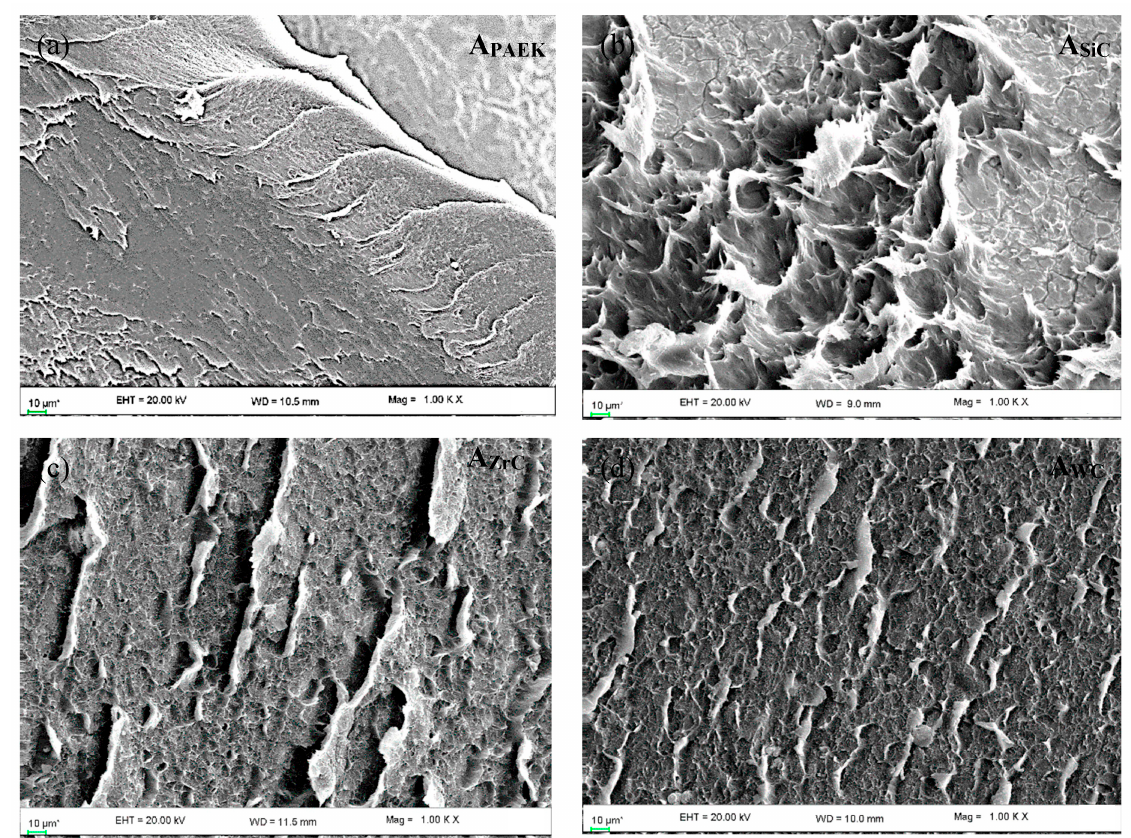
Figure 12. SEM mizcrographs for failed LSS joints ( a ) A PAEK , ( b ) A SIC , ( c ) A ZrC , and ( d ) A WC .